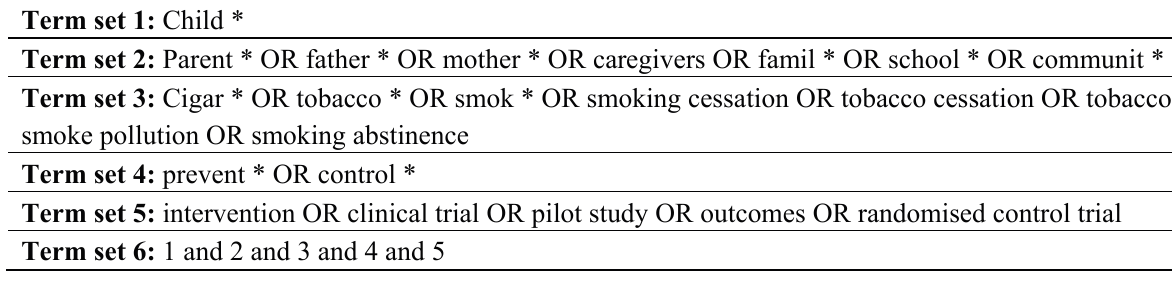
Table 1. Medline search